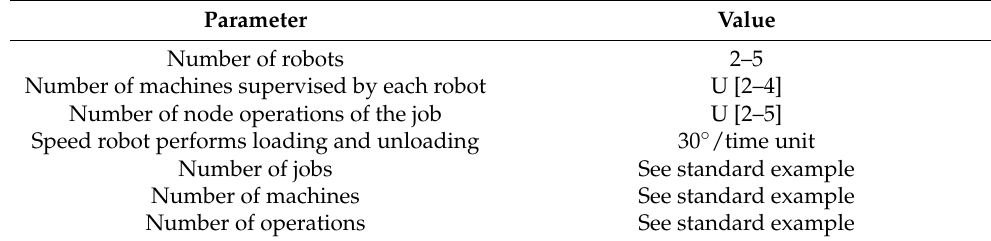
Table 2. Scheduling environment parameters.